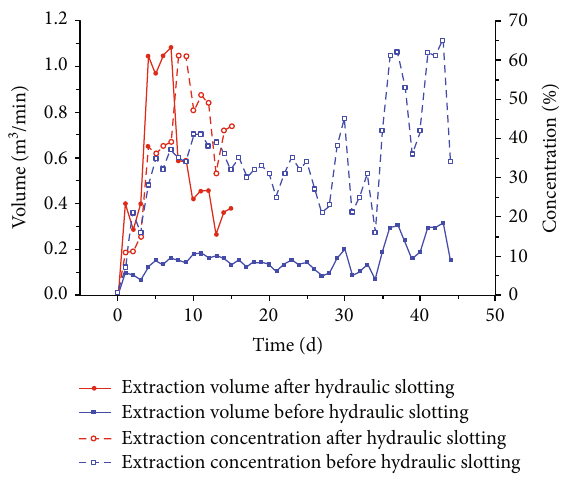
Figure 7: Gas extraction vs. time.